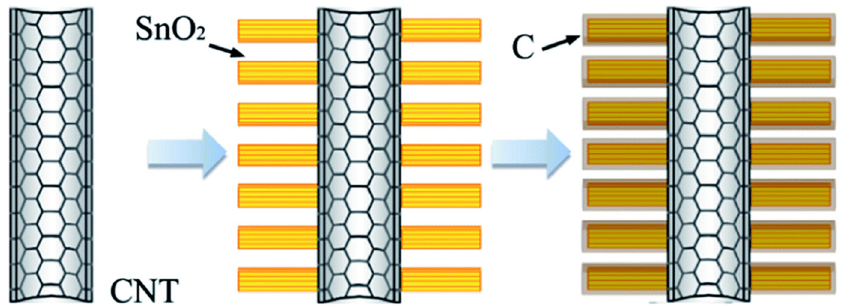
Figure 3. Schematic illustration of the formation of the branched MWCNT@SnO 2 nanorod@carbon heterostructures. Used with permission of The Royal Society of Chemistry from [44], Copyright© 2013; permission conveyed through Copyright Clearance Center, Inc.